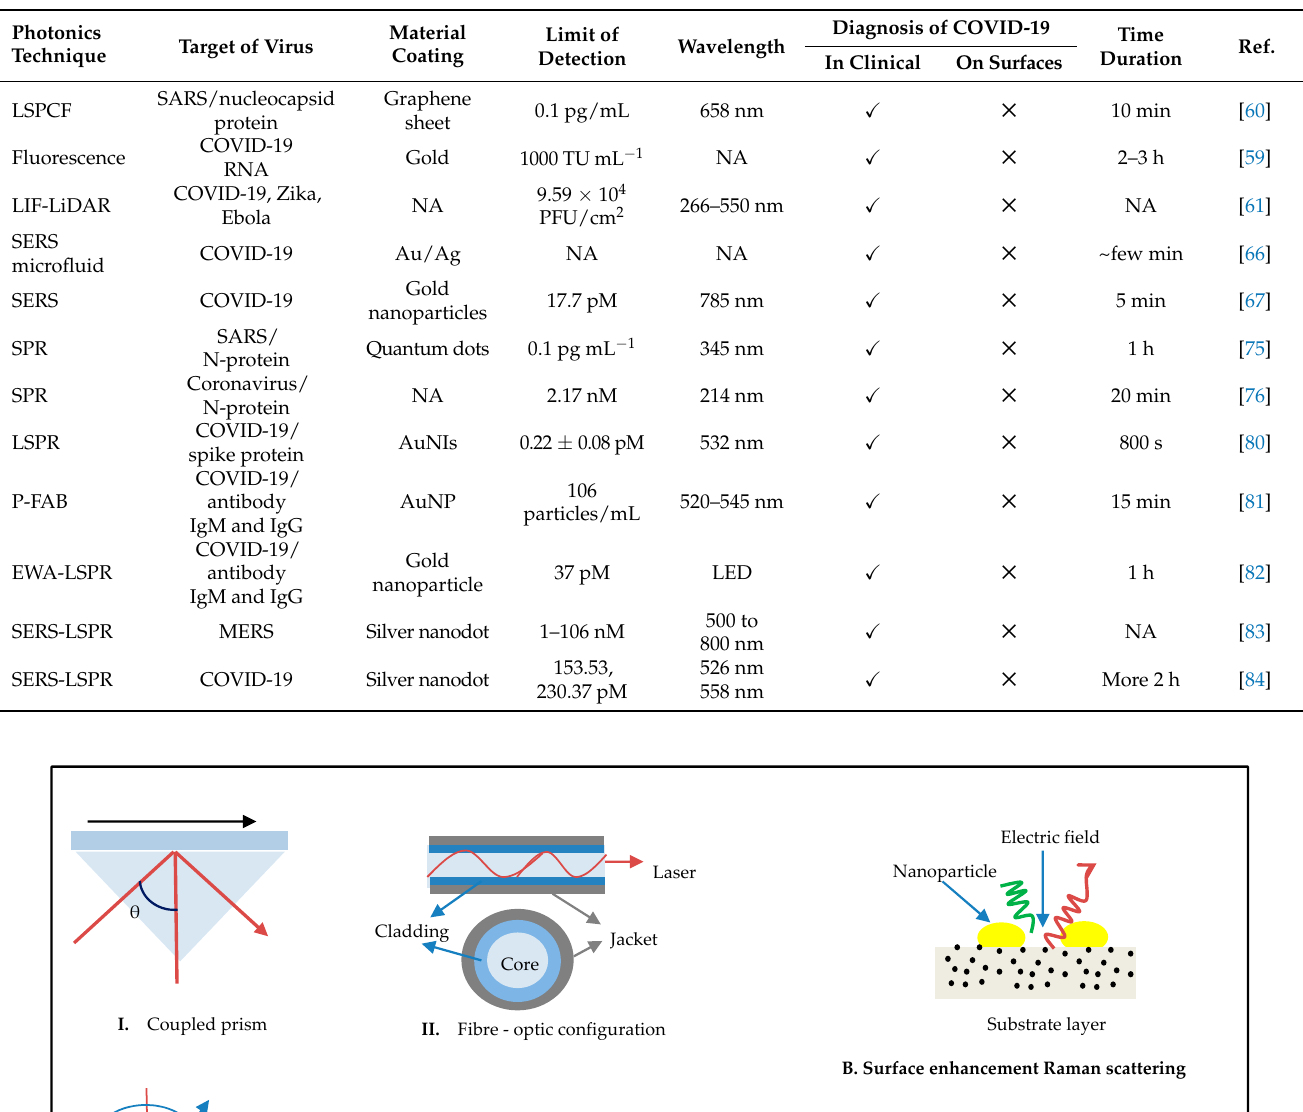
I. Coupled prism